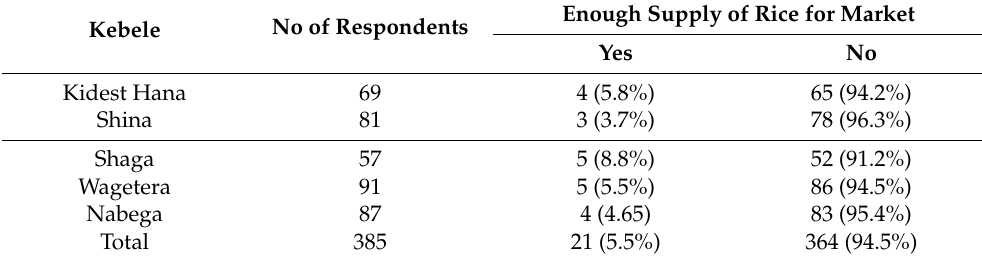
Table 4. Farmers’ understanding of supply of rice in the market. Kebele No of Respondents